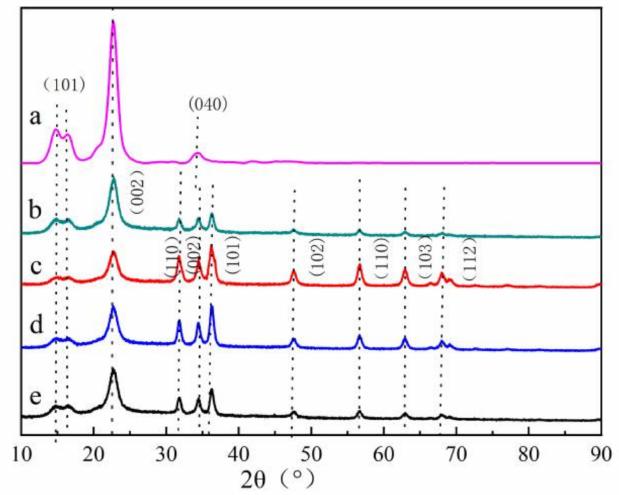
Figure 6. XRD patterns of raw cotton ( a ), ZnO/cotton ( b ), OA-ZnO/cotton ( c ), TA-ZnO/cotton ( d ), and SA-ZnO/cotton ( e ).